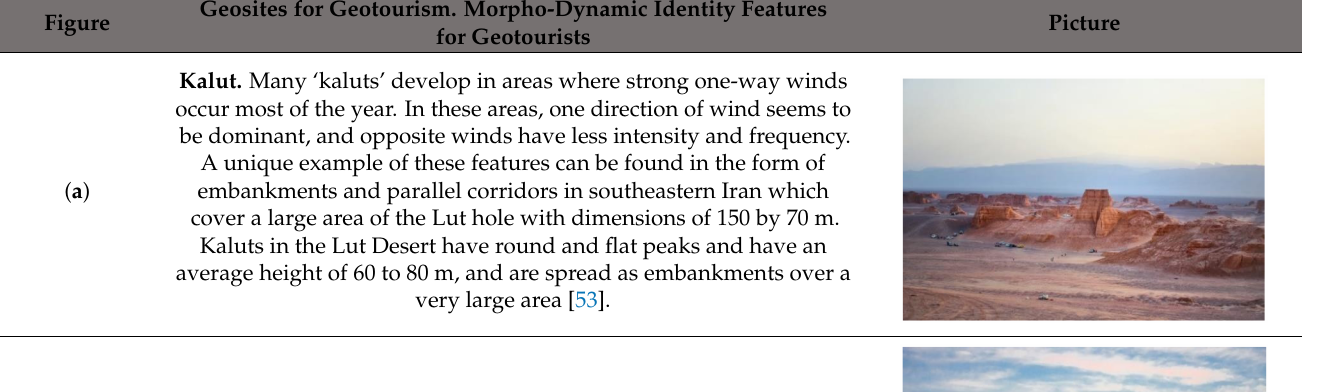
Geosites for Geotourism. Morpho-Dynamic Identity Features Figure for Geotourists